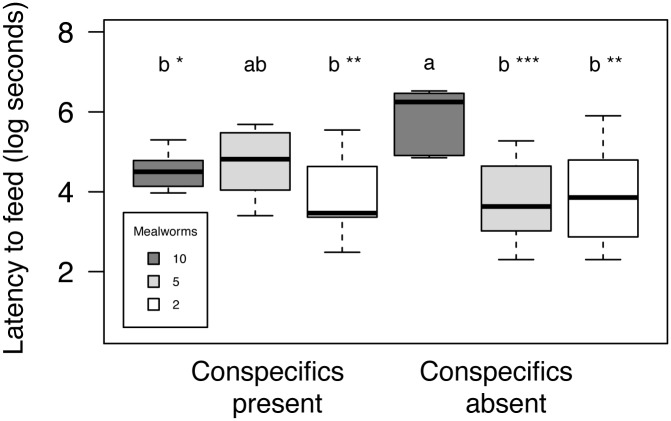
Latency to feed (log seconds) +/- SE for groups of individuals categorized according to the natural variation in presence or absence of conspecifics and three levels of experimentally manipulated food abundance (10, 5, and 2 mealworms).Comparisons among all six experimental treatments are provided. Letters “a” and “b” correspond to significantly different groups as analyzed using a Tukey's range test. Levels of significance are represented by ‘*’ (p < 0.10), ‘**’ (p < 0.05), and ‘***’ (p < 0.001).